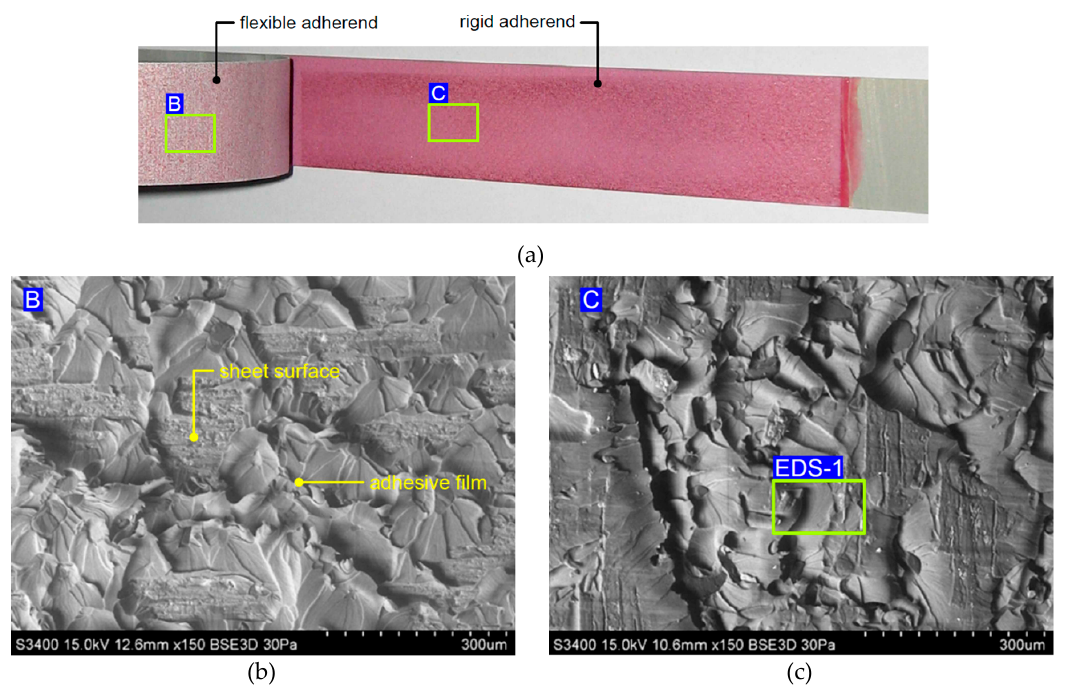
surfaces on the ( b ) flexible adherend and ( c ) rigid adherend. on the ( b ) flexible adherend and ( c ) rigid adherend. Materials 2020 , 12 , x FOR PEER REVIEW